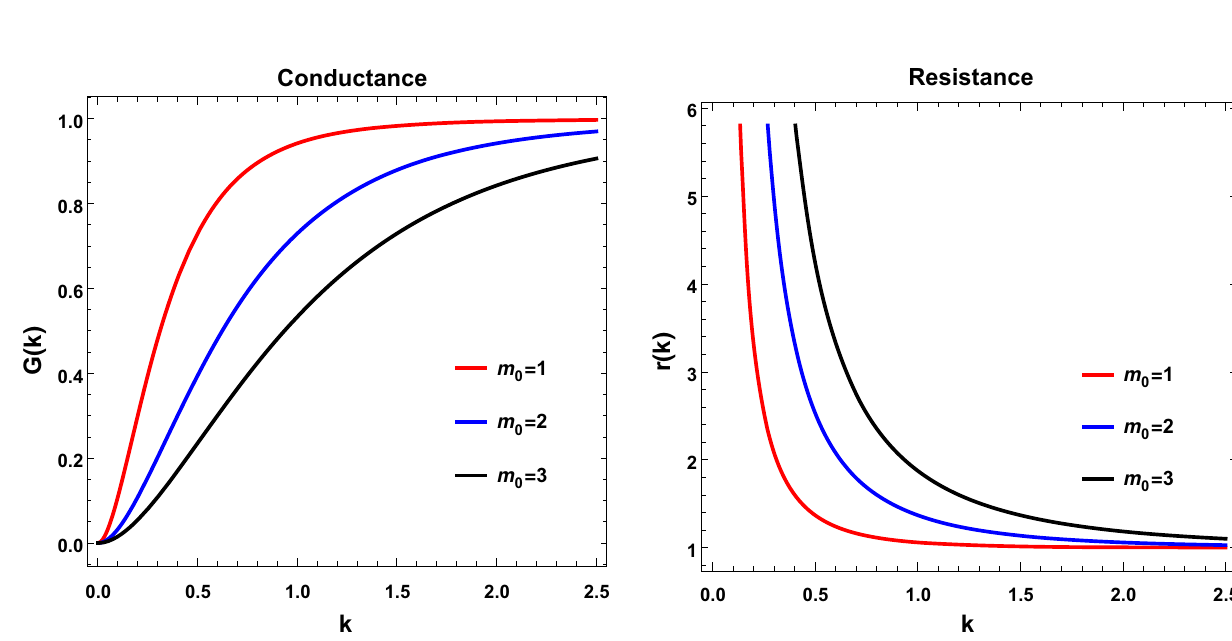
Fig. 19 Wave number dependence of conductance and resistance for the mass profile III is shown here